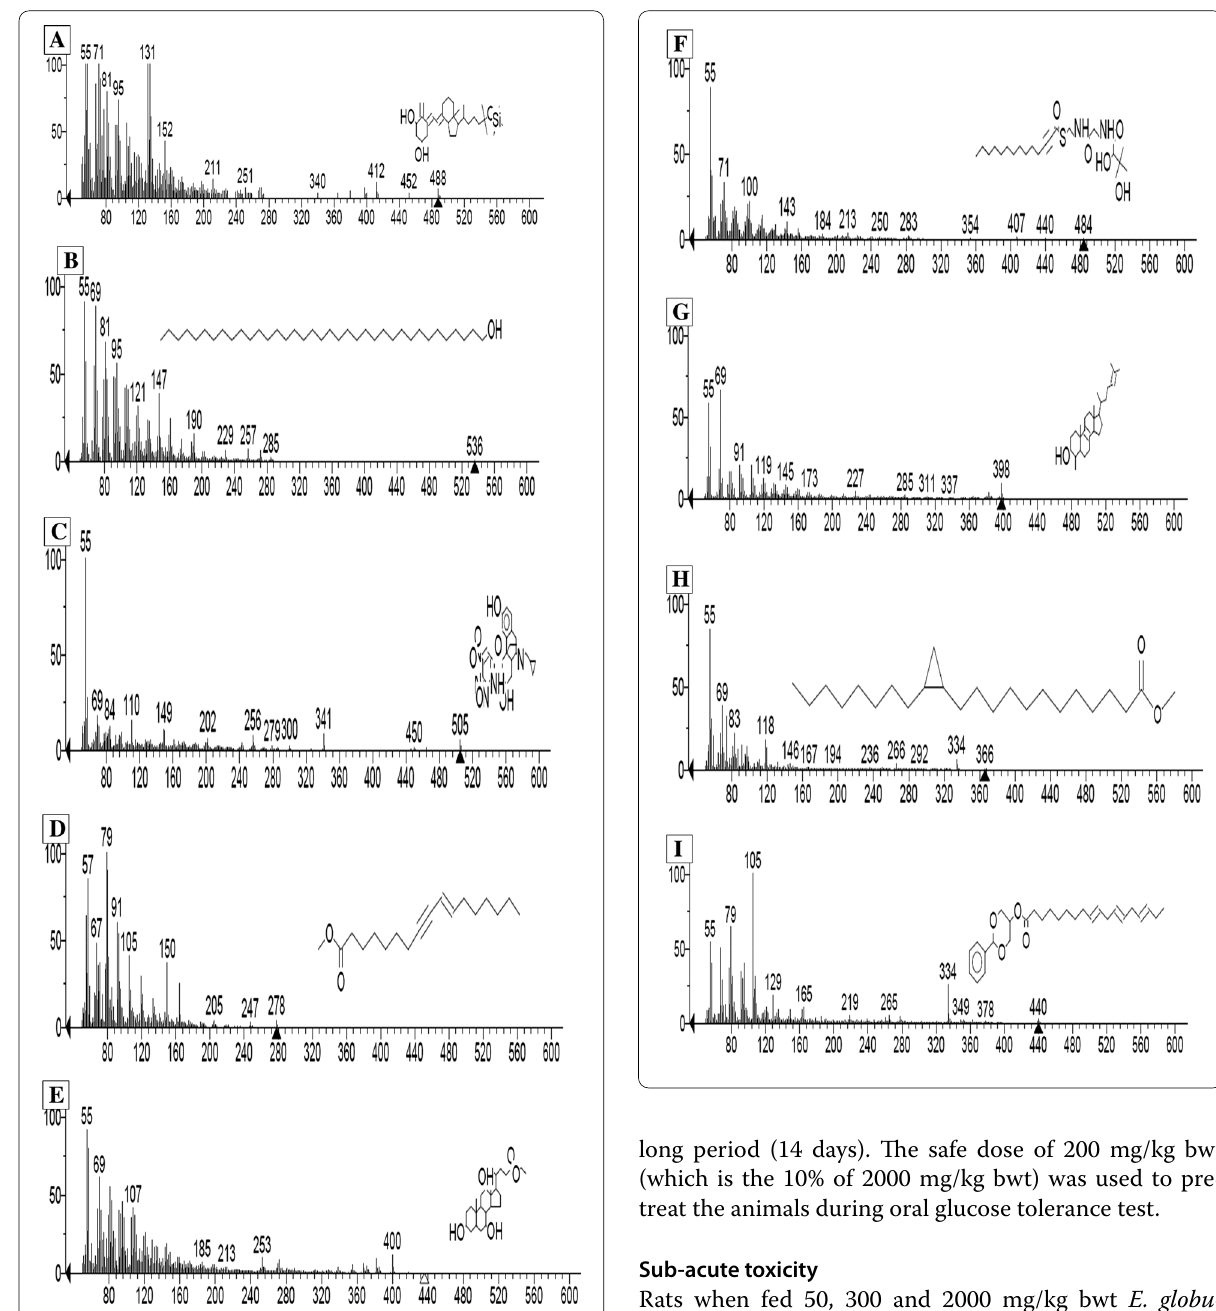
Fig. 2 Structures of the identified Compounds in Methanolic Leaf Extract of Eucalyptus globulus. A 19,10-Secocholesta = -5,7,10(19)-triene-1,3-diol,2[(trimethylsilyl)oxy] -(3β,5Z,7E)-; B 1-Heptatriacotanol; C Morphinan-4,5-epoxy-3,6-di-ol, = = 6-[7-nitrobenzofurazan-4-yl]amino-; D 10-Heptadecen-8-ynoic = acid, methyl ester, (E)-; E Ethyl iso-allocholate; F 2-Myristynoyl = = pantetheine; G Cholesta-8,24-dien-3-ol,4-methyl-, [3β,4α]-; = H Cyclopropanedodecanoic acid, 2-octyl-, methyl ester; = I 9,12,15-Octadecatrienoic acid, 2-phenyl-1,3-dioxan-5-yl ester =